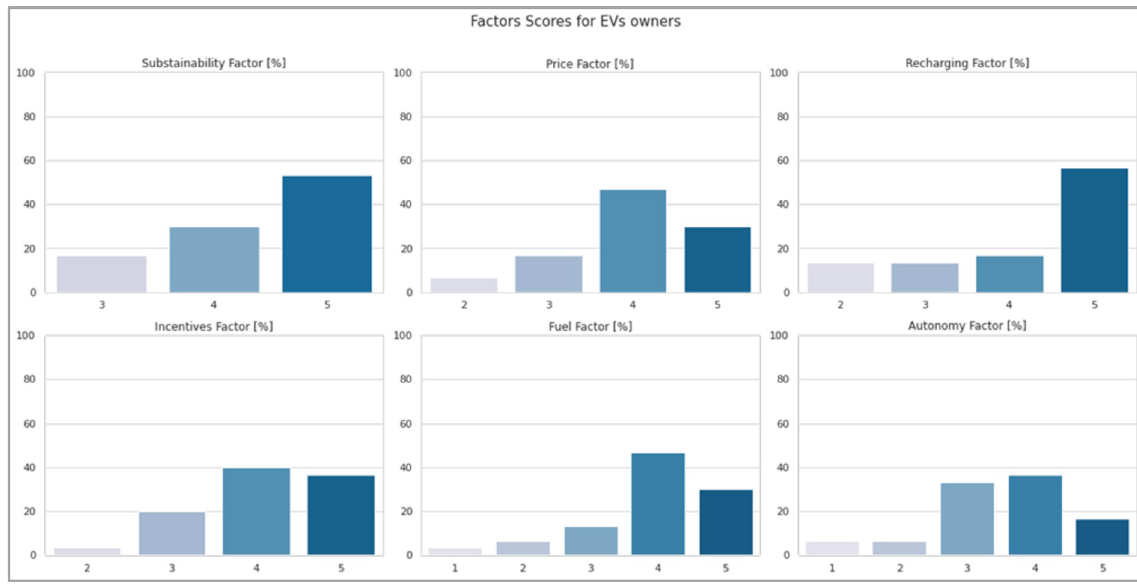
Fig 12. EVs owners’ opinion towards the main factors influencing the spread of EVs.